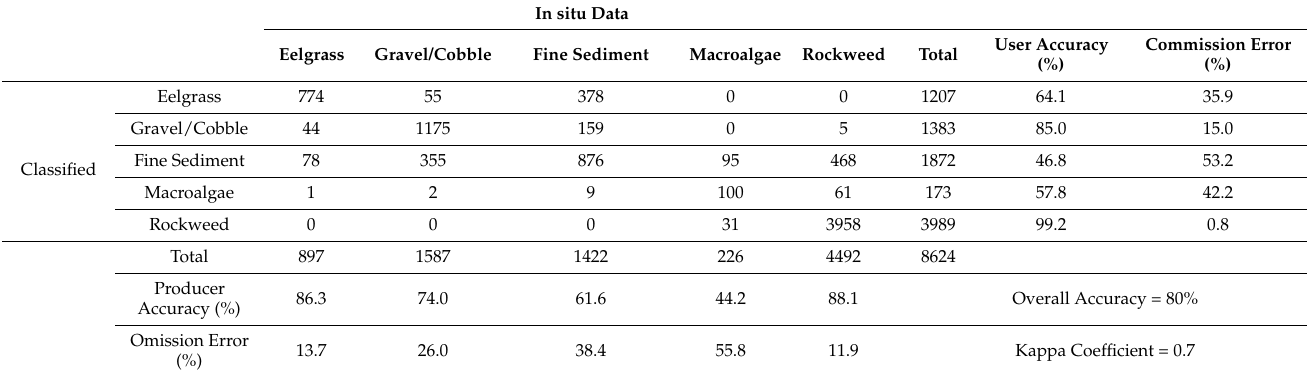
Table 3. Confusion matrix of the classification based on the Category 2